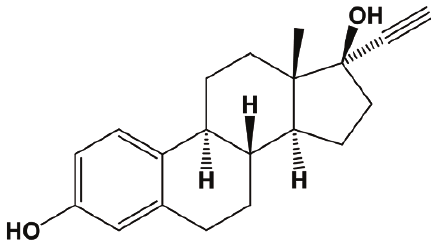
Figure 1. Molecular structure of